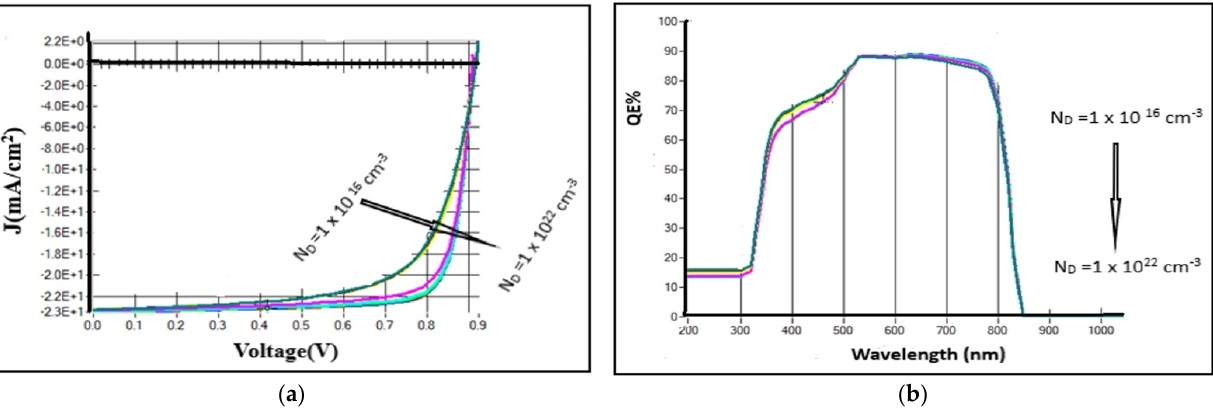
Figure 7. ( a ) J–V as a function of ZnSe donner carrier concentration ( N D ). ( b ) Spectral response of the enhanced quantum efficiency ( QE ) at longer wavelength with the increase in the donner carrier concentration ( N D ).